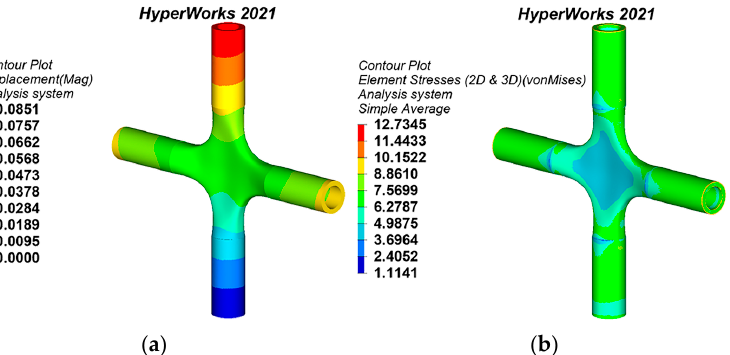
Figure 8. Static analysis results of generative joint 2: ( a ) displacement nephogram, ( b ) equivalent stress nephogram.